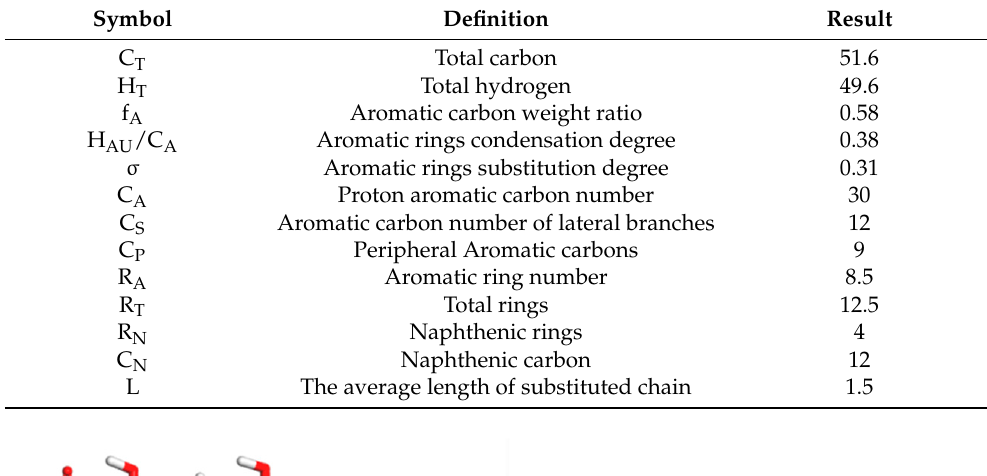
Table 7. Parameters and values of average asphaltene molecular structure.